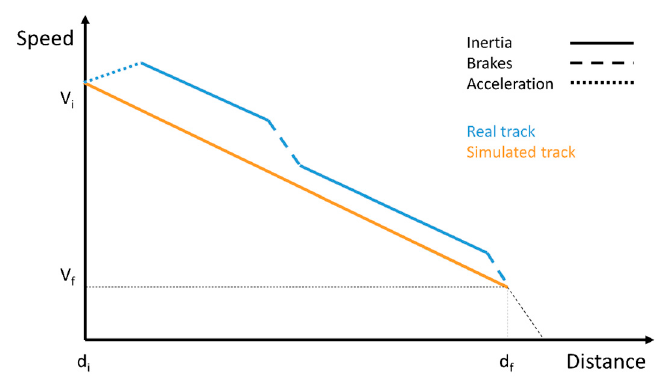
Figure 4. Pattern of Perfect Inertia (Simulated) Compared with the Use of Brakes (Real).